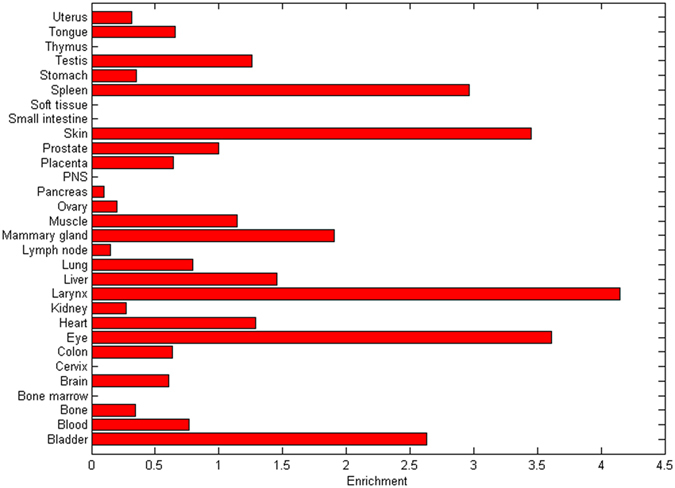
Tissue-specific expression analysis in the MCC gene.The expression level is normalized with tissue-library size. Each value for a gene in a tissue is a ratio of observed ESTs (Expressed Sequence Tags) to the expected one in this tissue. The expected number of ESTs is the product of total ESTs of the gene and the fraction of total ESTs in the tissue among all ESTs in 30 tissues.